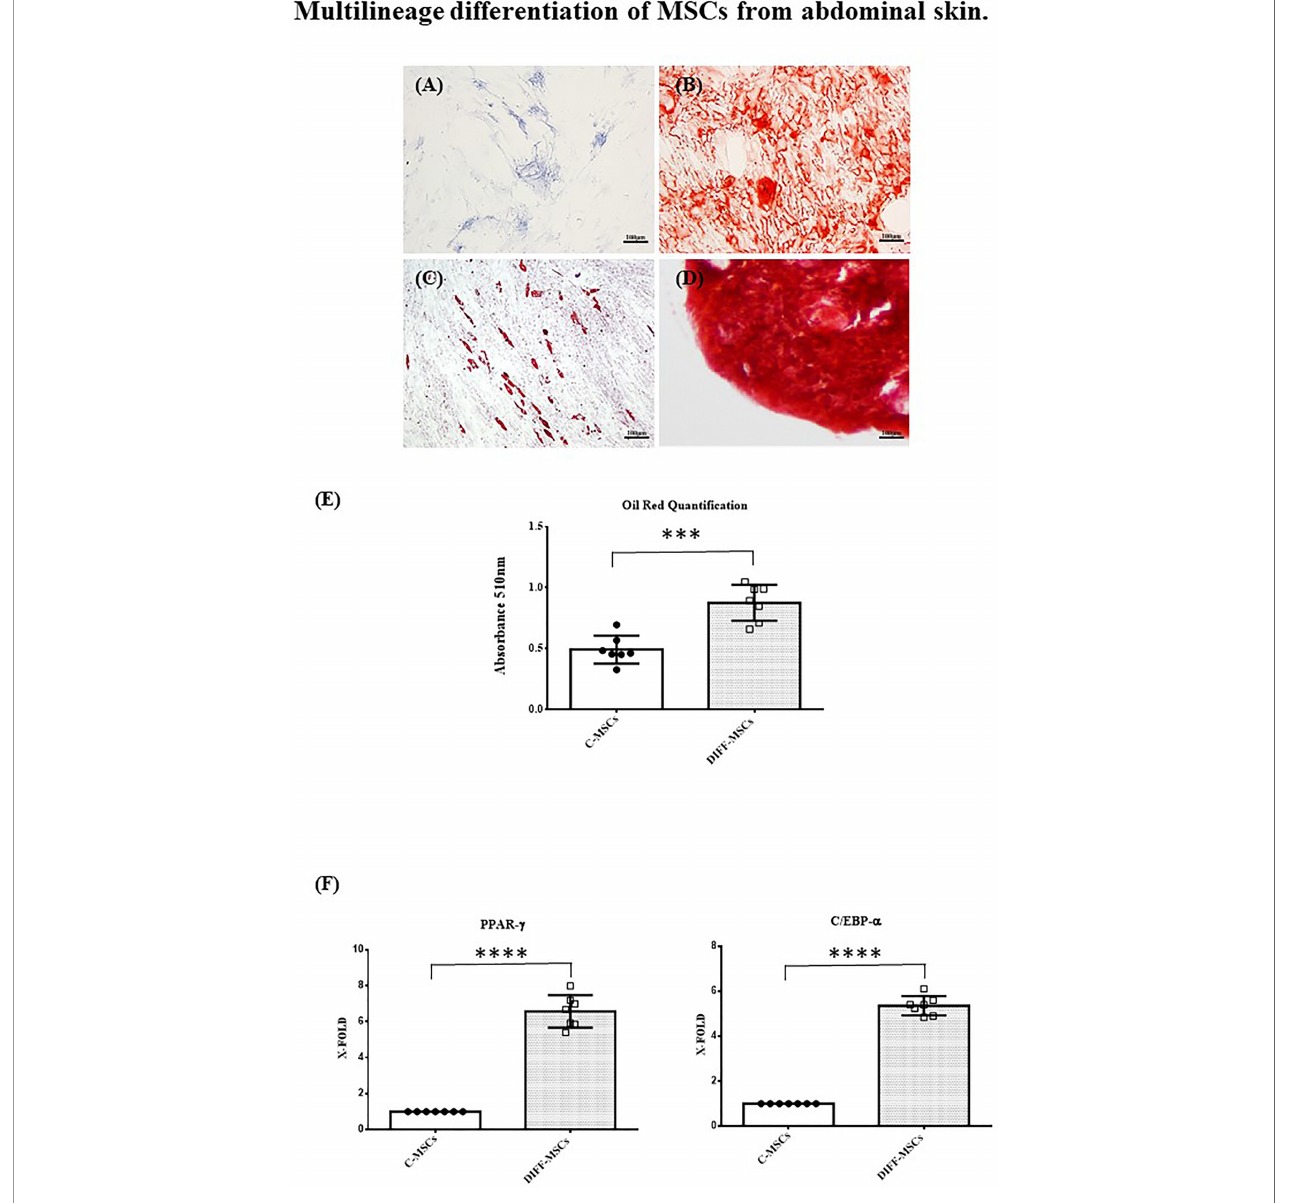
FIGURE 2 | Multilineage differentiation of MSCs from abdominal skin. Representative images of MSCs derived from the seven patients and differentiated towards osteogenic lineage as assessed by ALP reaction ( A , Scale bar 100 m m) and Alizarin red staining ( B , Scale bar 100 m m); chondrogenic lineage as indicated by Safranin- O staining ( C , Scale bar 100 m m); adipocyte lineage as con fi rmed by Oil red staining ( D, Scale bar 100 m m); (E) Oil Red staining quanti fi cation. Data are expressed as mean ± SD of the absorbance read for undifferentiated and differentiated cells (C-MSCs and DIFF-MSCs respectively). (F, G) Expression of PPAR- g and C/EBP- a by RT-PCR in differentiated vs undifferentiated MSCs towards adipogenic lineage. Data are expressed as mean ± SD (over three independent experiments) of the X-fold (2 − DD Ct method) of differentiated MSCs compared to undifferentiated MSCs, arbitrarily expressed as 1, where D Ct=Ct (gene of interest) — Ct (control gene) and D ( D Ct) = D Ct (DIFF-MSCs) — D Ct (C-MSCs). Unpaired t-Student ’ s test; ***p<0.001,